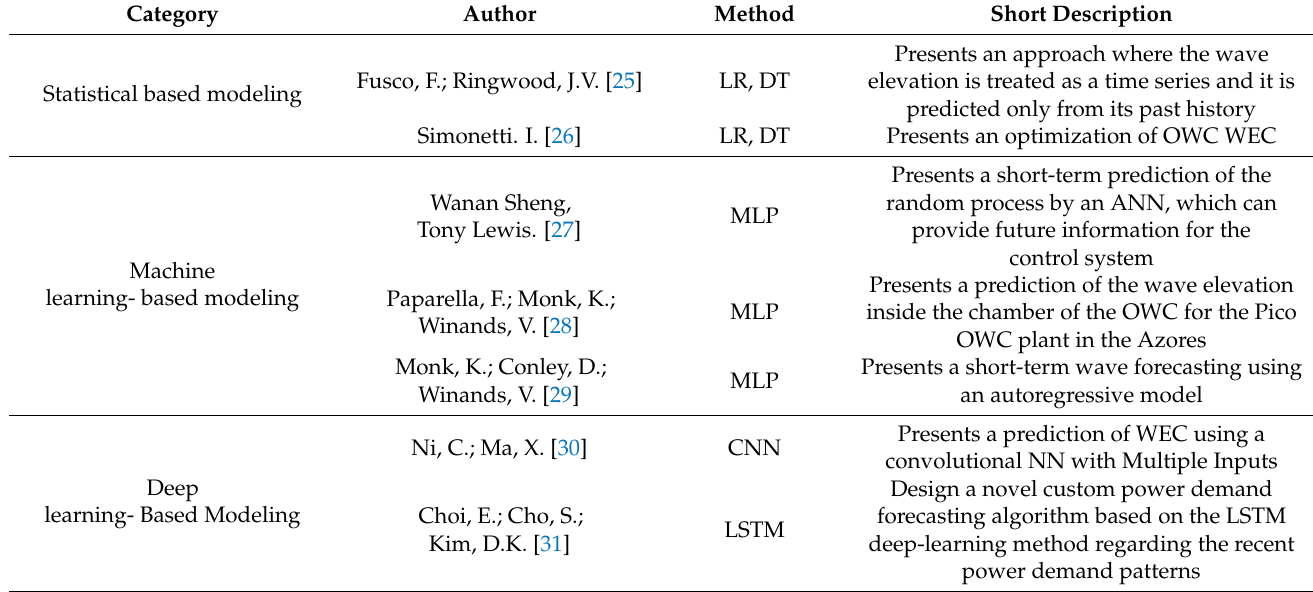
Table 2. Deep-learning models in WEC.